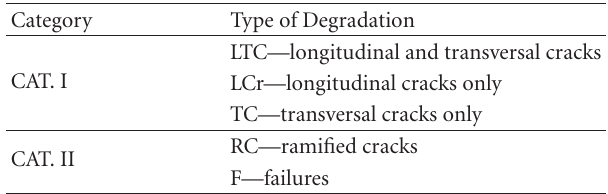
Table 2: Classification of road pavement degradation into two categories.